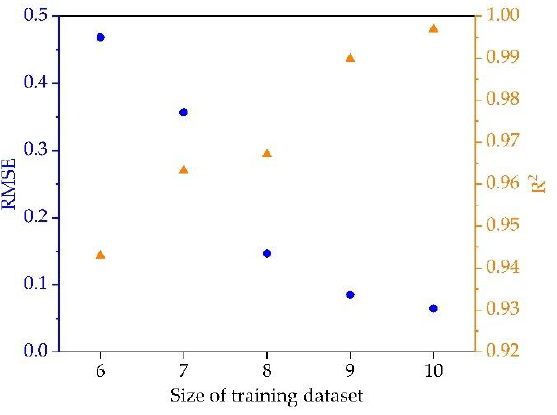
Figure 5. The reliable results of the GPR model versus size of training dataset.